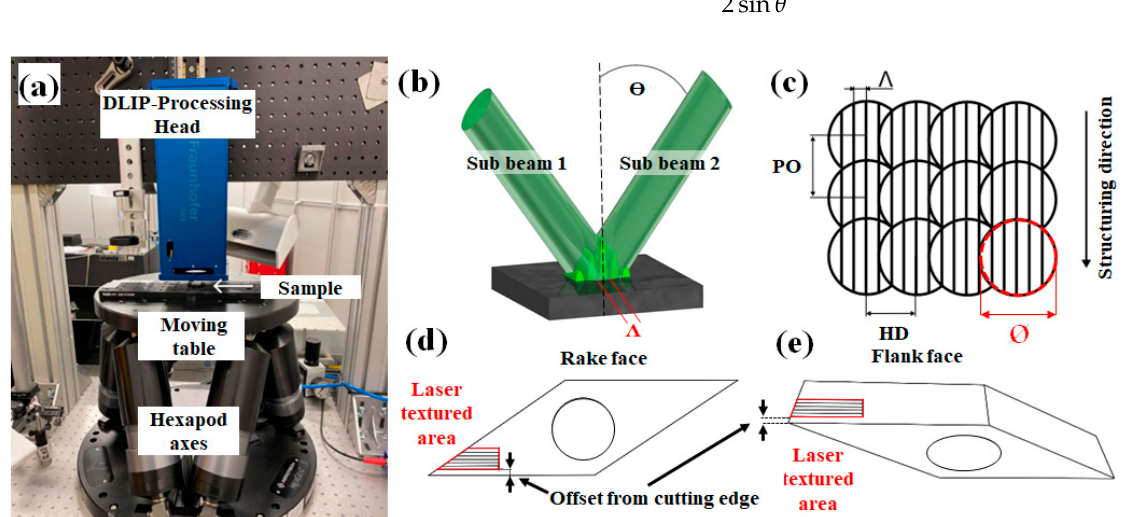
Figure 1. Experimental setup ( a ), schematic image of the intensity distribution and definition of the spatial period Λ ( b ), principle drawing of the texturing process strategy ( c ), top view of a schematic drawing of the rake face with the location of the laser processed area ( d ) and side view onto the flank face of a cutting tool with the schematic location of the laser processed zone ( e